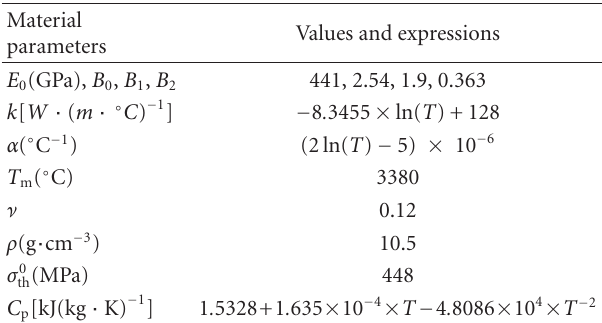
Table 1: Temperature-dependent material parameters of HfB 2 [2, 18,